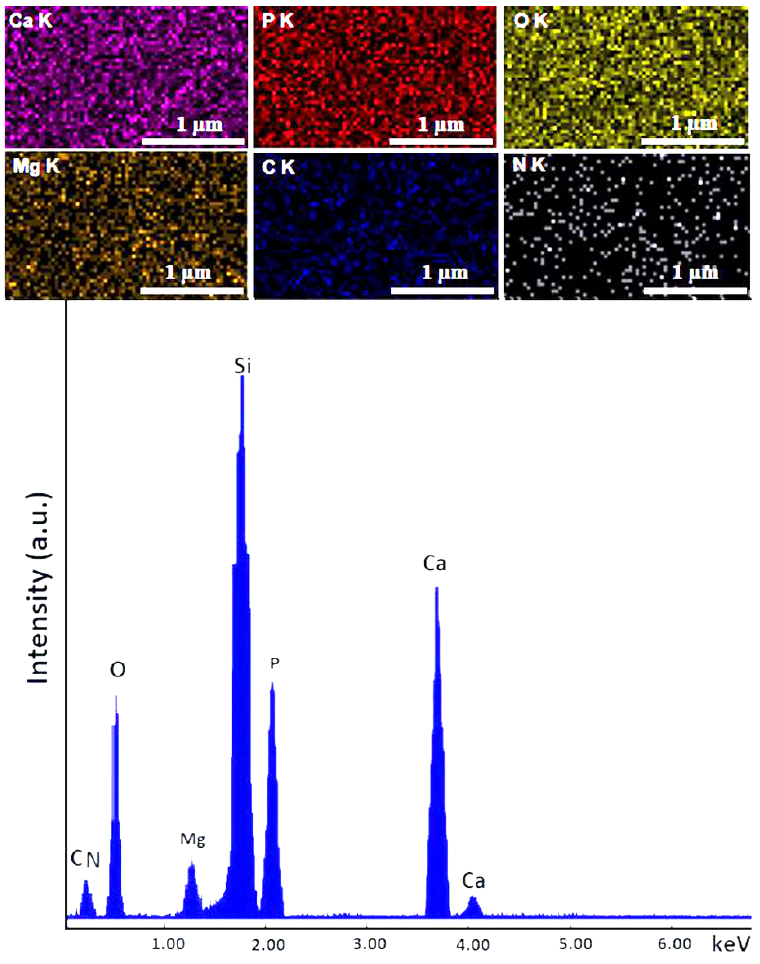
Figure 5. Elemental mapping distribution and EDX spectra of 30MgHApCh composite coatings. Table 2. Concentration of Ca, P, O and Mg